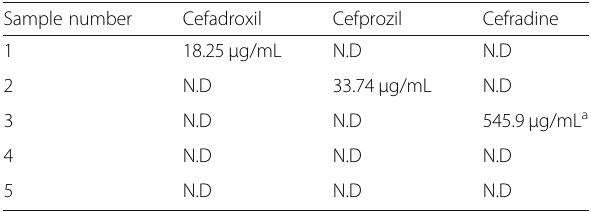
Table 4 Concentrations of three cephalosporin antibiotics in pharmaceutical wastewater samples Sample number